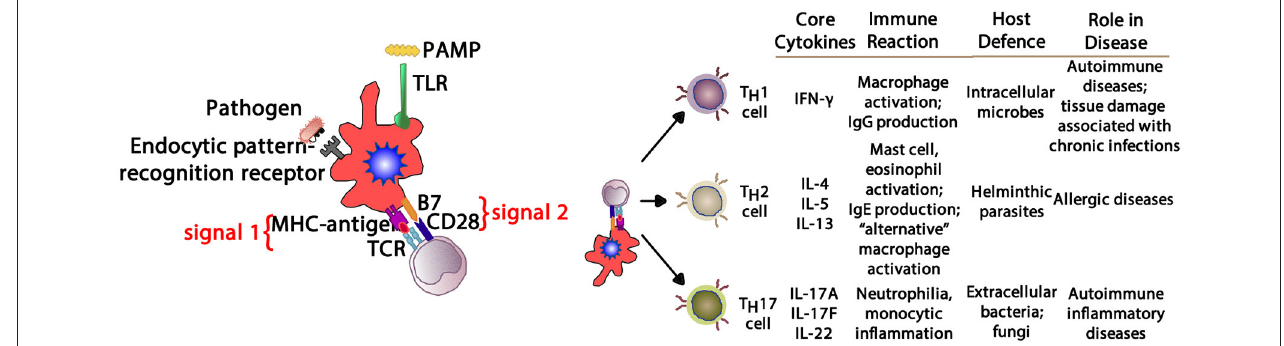
FIGURE 6 | Depending upon the cytokine milieu present at the time of antigen presentation (signal 1) and costimulation (signal 2), three T cell polarization pathways can develop. IFN- γ supports T H 1 deviation that mediates macrophage-mediated reactions. IL-4, IL-5, and IL-13 create a T H 2 environment that drives eosinophil and IgE production. IL-17A, IL-17F, and IL-22 provide aT H 17 environment driving neutrophilic and some autoimmune phenomena. PAMP, pathogen-associated molecular pattern; TLR, toll-like receptor; MHC, major histocompatibility complex; TCR, T cell receptor; IFN- γ , interferon-gamma; IgG, immunoglobulin G; IgE, immunoglobulin E; IL-4, interleukin-4; IL-5, interleukin-5; IL-13, interleukin-13; IL-17A, interleukin-17A; IL-17F, interleukin-17F; IL-22, interleukin-22.